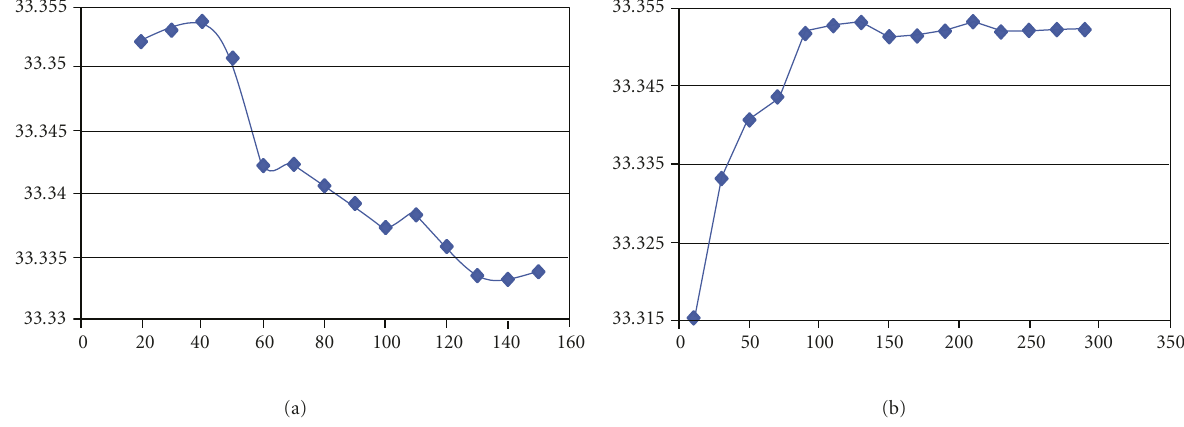
Figure 9: Performance of the proposed algorithm at di ff erent settings of threshold T G and T K : (a) threshold T K and (b) threshold T G